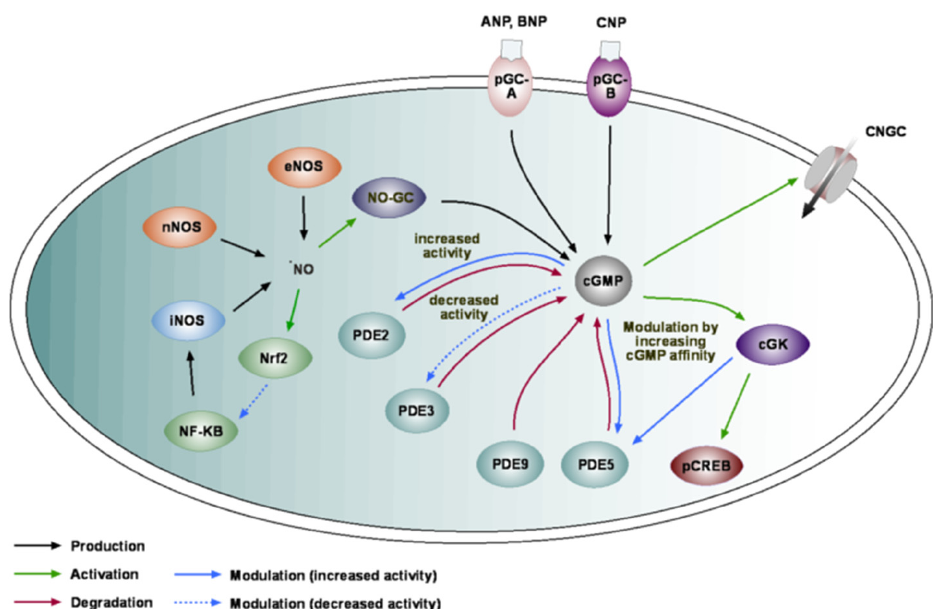
Figure 1. cGMP signaling pathway. cGMP production is induced via activation of either NOS or natriuretic peptides (NPs). NO activates NO-GC in the cytosol, and pGC-A and pGC-B produce cGMP in the membranous fraction. cGMP stimulates cGK, which phosphorylates target proteins. cGMP is degraded by PDEs. PDE5 and 9 are cGMP-specific, and PDE1, 2, 3, and 10 are dual-substrate PDEs, degrading both cAMP and cGMP. NOS: nitric oxide synthase; iNOS: inducible NOS; eNOS: endothelial NOS; nNOS: neuronal NOS; NO-GC: soluble guanylate cyclase; Nrf2: Nuclear factor erythroid 2-related factor 2 cGMP: cyclic guanosine-3 ′ ,5 ′ -monophosphate; NF- κ B: nuclear factor κ B; ANP: atrial natriuretic peptide; BNP: brain natriuretic peptide; CNP: C-type natriuretic peptide; pGC-A: particulate guanylate cyclase A; pGC-B: particulate guanylate cyclase B; cGK: cyclic guanosine monophosphate-dependent protein kinase, also known as protein kinase G (PKG); PDE: phosphodiesterase; CNCG: cyclic nucleotide-gated channel; pCREB: phosphorylated cyclic adenosin monophosphate (cAMP) response element-binding protein.